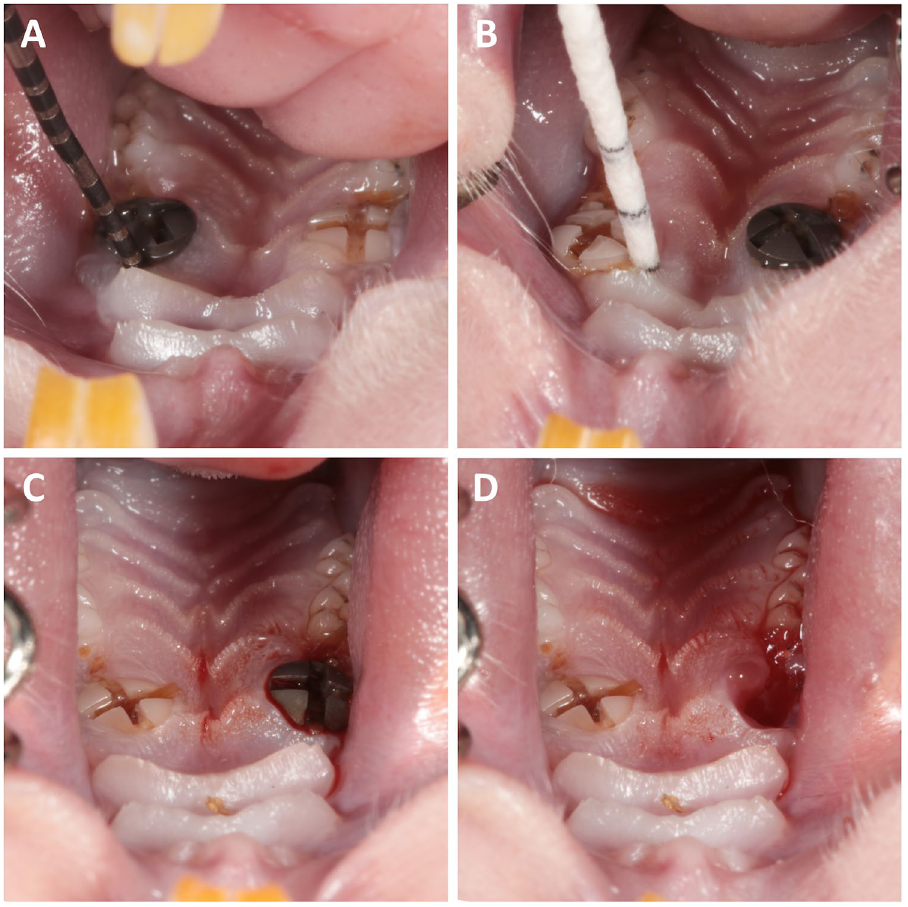
Figure 2. ( A ) Intraoral view of the upper jaw. The clinical probing pocket depth was measured with a dental probe. ( B ) In vivo material were collected with sterile color-coded paper points. ( C ) The sulcus bleeding index was evaluated around each implant (SBI around the titanium implant was 3 = severe bleeding). ( D ) In this case due to peri-implantitis and loss of stability, the titanium implant had to be